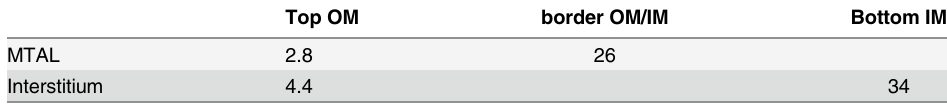
Table 8. Potassium gradients (mM) assumed in the model. Top OM border OM/IM Bottom IM MTAL 2.8 26 Interstitium 4.4 34 Potassium assumptions based on [13, 14, 66, 67]. Potassium concentrations are de fi ned at the entry and exit of the medullary thick ascending limbs (MTAL) and interstitium, and elsewhere linearly interpolated. At the entry of the collecting ducts, potassium concentration is initialized at 20mM and is included in the calculation of osmotic pressure (potassium fl ow is assumed to be constant in this tube, so its concentration increases as volume fl ow decreases along the CD) as in [17].